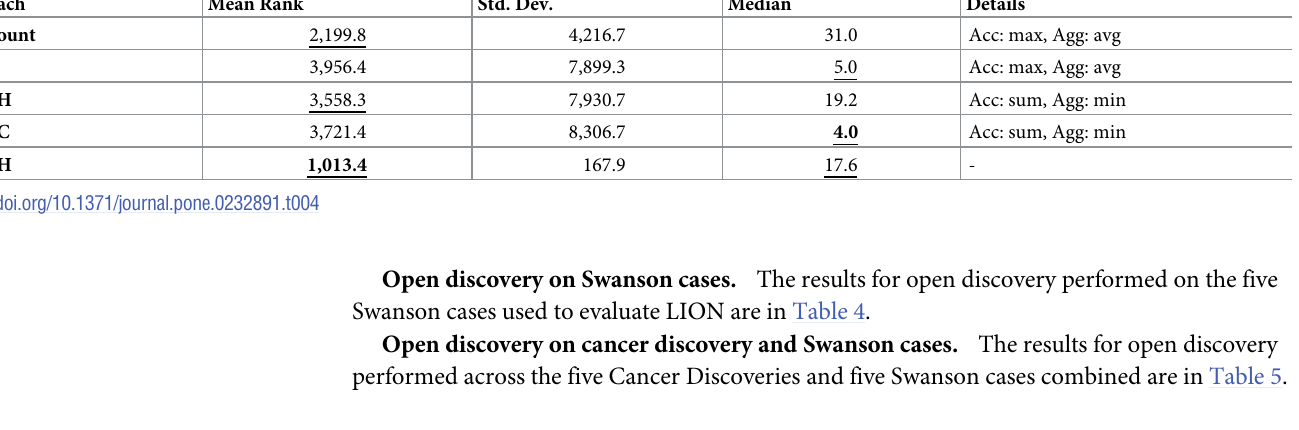
Table 4. Open discovery: Mean and median ranks on the Swanson cases. Approach Mean Rank